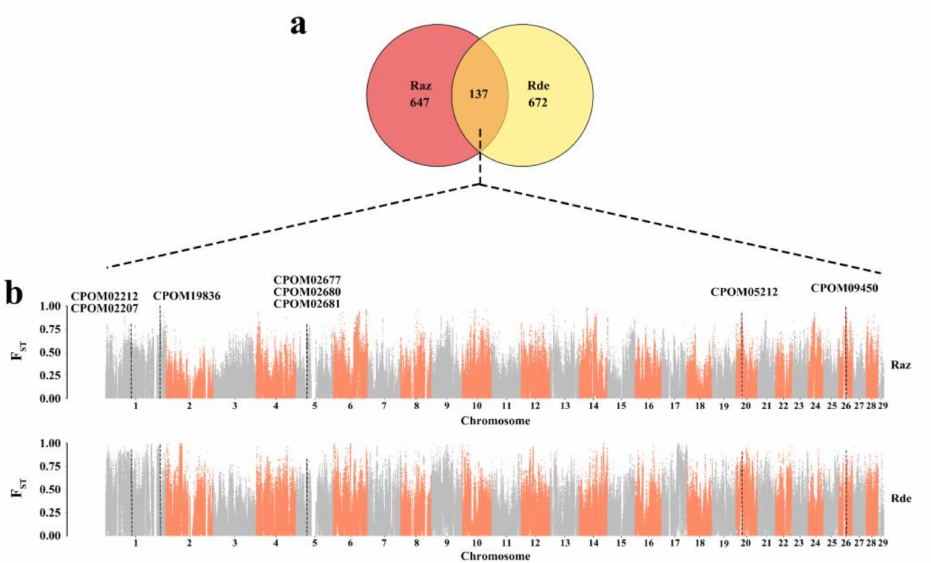
Figure 2. Location in genome and F ST value of eight PSGs detected both in Raz and Rde strains of C. pomonella , respectively. ( a ) Venn diagram illustrating the number of common and unique PSGs detected in the Raz and Rde strains. ( b ) F ST values of the eight resistant-related genes involved in cross-resistance. X-axes represent the location of genome, and orange and grey areas represent the chromosomes 1–29. Dotted lines parallel to the y -axis show the location in genome of eight PSGs. The Specific F ST values were showed in Table 1.